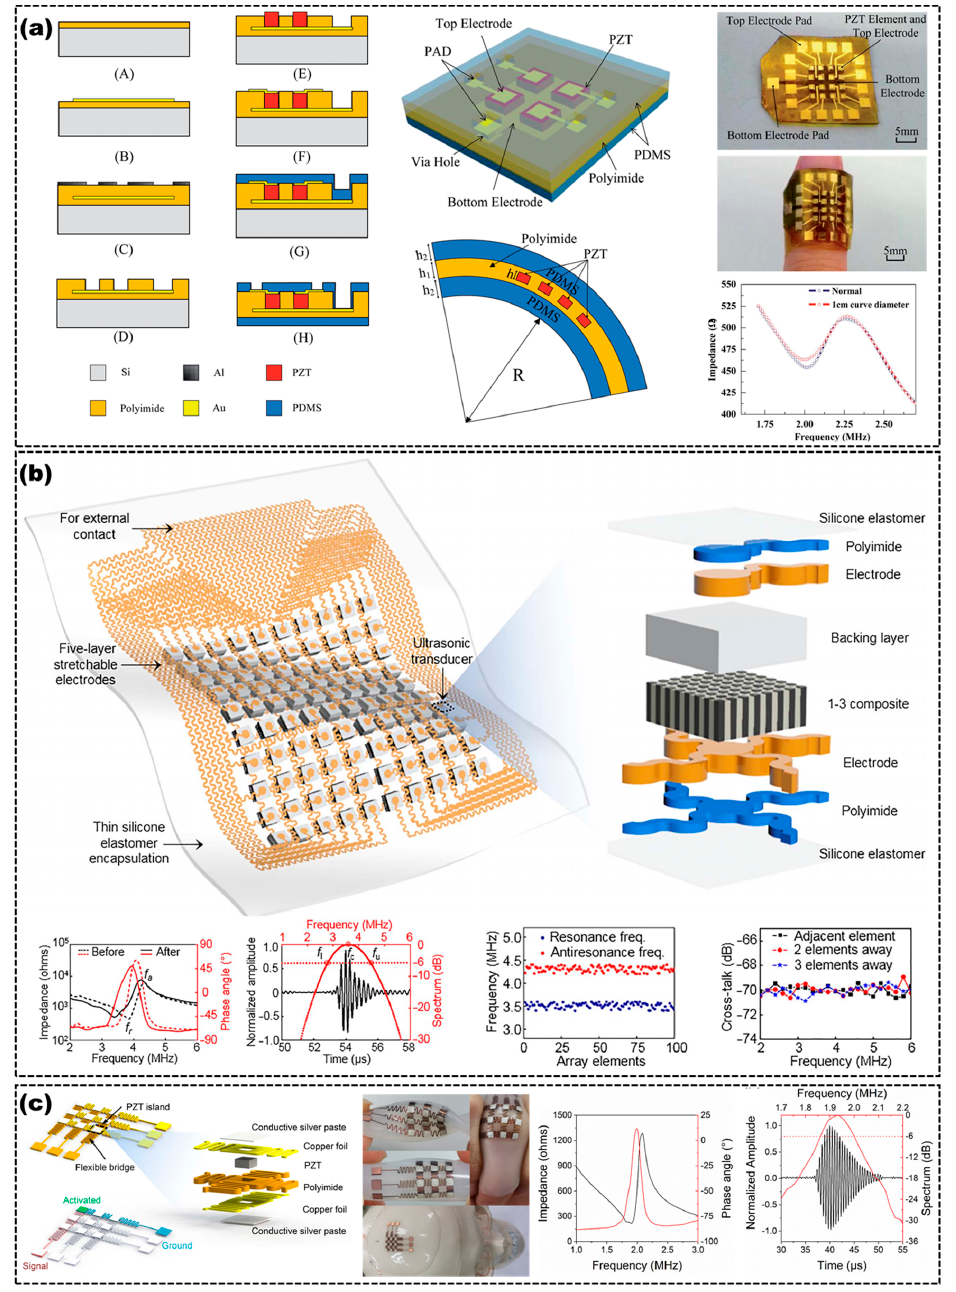
Figure 5. ( a ) Fabrication process ( top left ), illustration ( middle ), photographs ( top right ) and impedance curve in different states ( bottom right ) of the 2 − flexible array transducer. Adapted from [39]. ( b ) Schematics ( top ), impedance curve ( bottom first ), frequency spectrum ( bottom second ), resonance and antiresonance frequency variations ( bottom third ) and average cross ‐ talk levels ( bot ‐ tom fourth ) of a 2 − D flexible array US transducer. Adapted from [23]. ( c ) Schematics ( left ), optical images ( second left ), impedance curve ( third left ) and frequency spectrum ( right ) of the flexible 2 − D array US transducer. Adapted from [17].